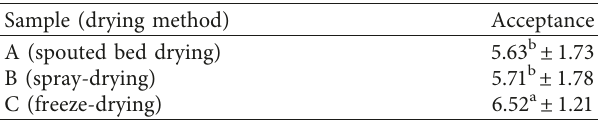
Table 5: Mean of the acceptance ∗ of the mixed juice made with ACMP obtained by different drying methods ( n �